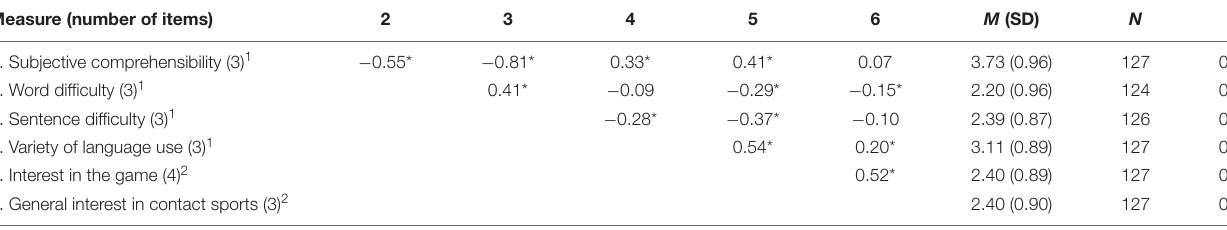
TABLE 3 | Psychometric properties and intercorrelations between the variables in Experiment 2. Measure (number of items)